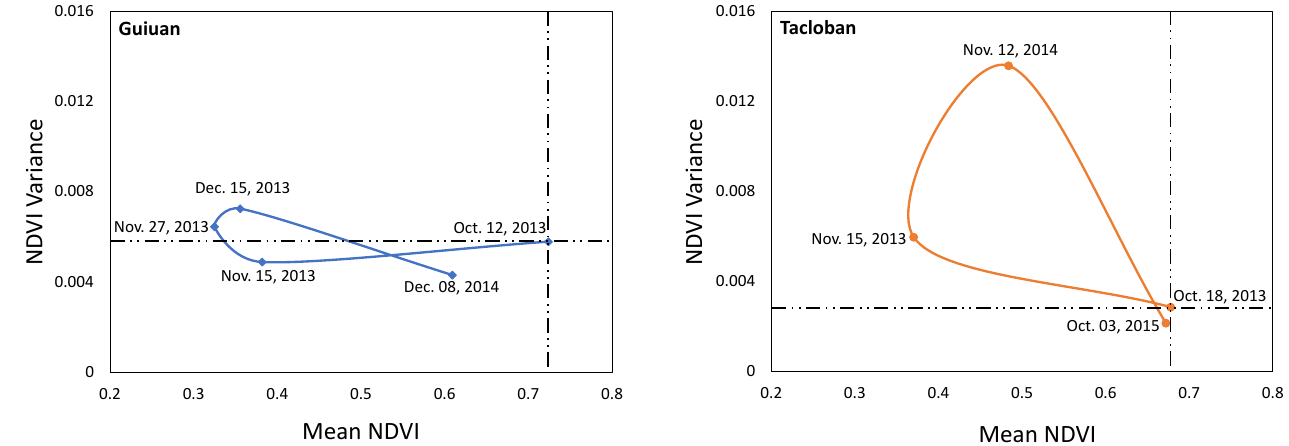
Figure 14. Mean-variance analysis of the Guiuan and Tacloban study